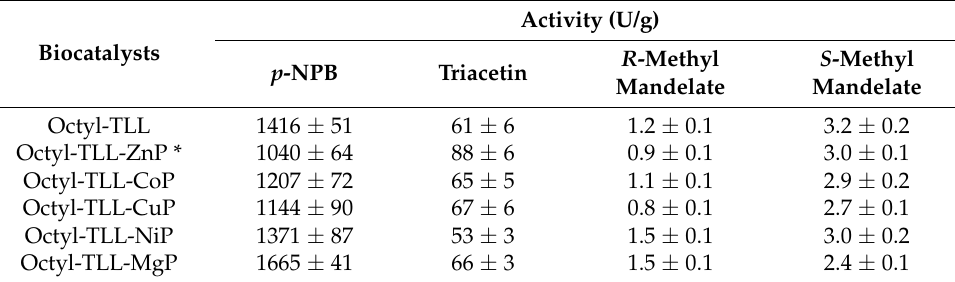
Table 2. Specific activity of different TLL biocatalysts with 1 mM p -NPB (pH 7 and 25 ◦ C), 50 mM triacetin (pH 7 and 25 ◦ C), and 50 mM R - or S -methyl mandelate (pH 7 and 25 ◦ C). Experiments were conducted as described in